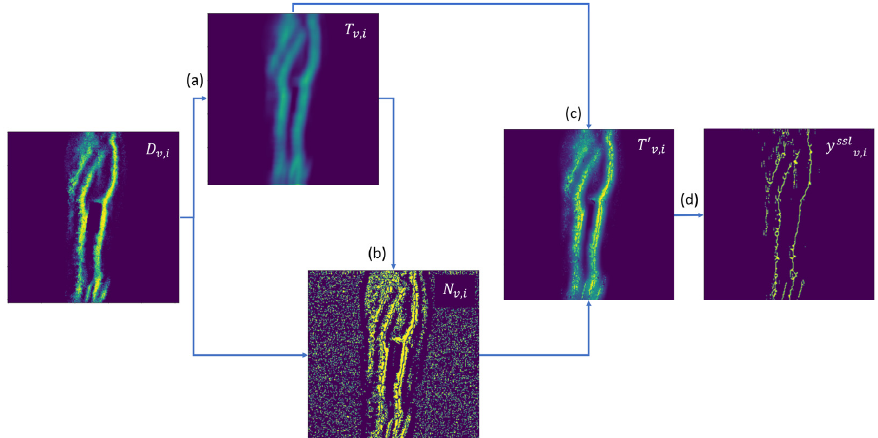
Figure 7. Overview 2D Label Generation components: ( a ) Niblack thresholding is applied on the prediction density map D , followed by a simulated annealing process, resulting in a local thresh ‐ old map T ; ( b ) The local threshold map T is applied to D to get a binarized image of vein candidate pixels, from which N , a map of noise pixels, is extracted via morphological operations; ( c , d ) For every noise pixel found in N , the corresponding value in T is set to D , with results stored in T ′ . Segmented label 𝑦 (cid:3046)(cid:3046)(cid:3039) is then computed as D > T ′ , to be used as a supervision signal for model (cid:3049),(cid:3036)